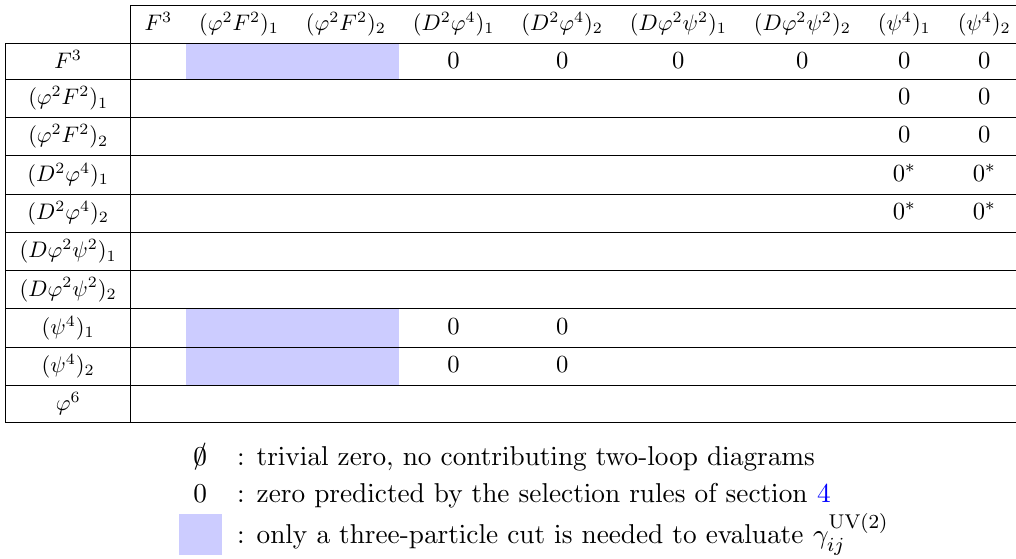
Table 4 . Structure of the two-loop anomalous dimension matrix (cid:13) (2) due to the collected rules ij outlined in this section. A = 0 indicates there are no contributing two-loop diagrams, whereas 0 alone indicates that there are one-loop diagrams that could contribute, but the anomalous dimension evaluates to zero. A 0 (cid:3) indicates the result is nonzero in MS, but set to zero by introducing the appropriate (cid:12)nite counterterms. Shading indicates the entry depends only on the three-particle cut, due to either the length selection rules of section 4.1 or the vanishing of the relevant one-loop amplitudes. As for table 2, the operators labeling the rows are renormalized by the operators labeling the